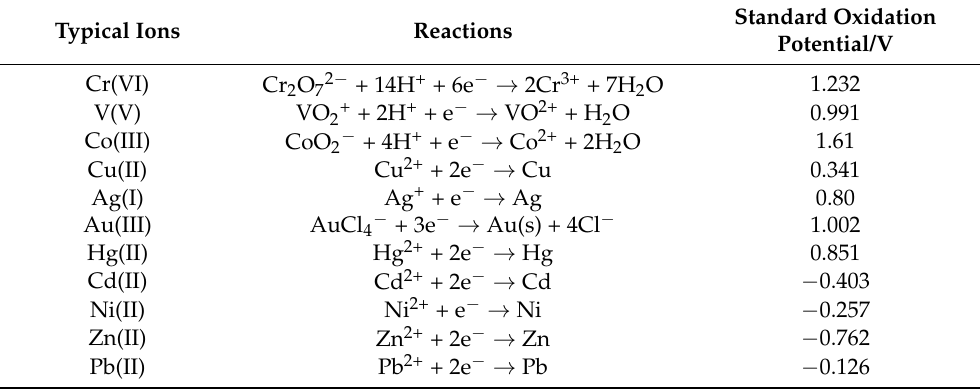
Table 1. Oxidation potentials for typical metal